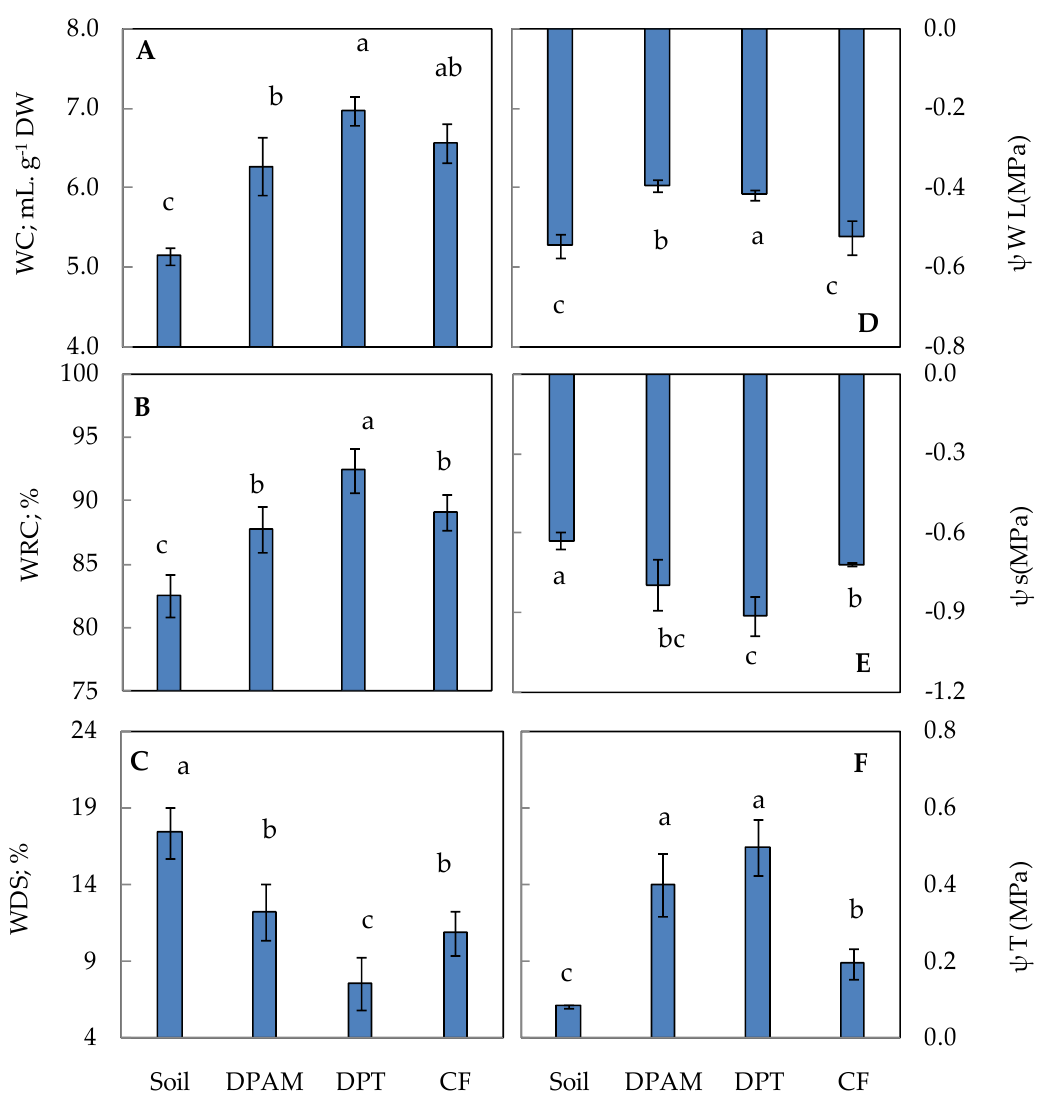
Figure 1. Variation in water parameters in leaves of tomato plants cultivated on different substrates. DPAM: compost of date-palm residues and animal manure; DPT: compost of date-palm trunk; CF: coconut fiber, compared with soil substrate. ( A ): Water content (WC: mL g − 1 DW); ( B ): relative water content (RWC: %); ( C ): water saturation deficit (WSD: %); ( D ): water potential ( Ψ w; MPa); ( E ): solute potential ( Ψ s; MPa); ( F ): pressure (turgor) potential ( Ψ p; MPa). The plants were 5 months old. The results comprise the mean of six replicates ± S.D. Numbers followed by a different letter within a panel are significantly different at p ≤ 0.05, according to LSD analysis.